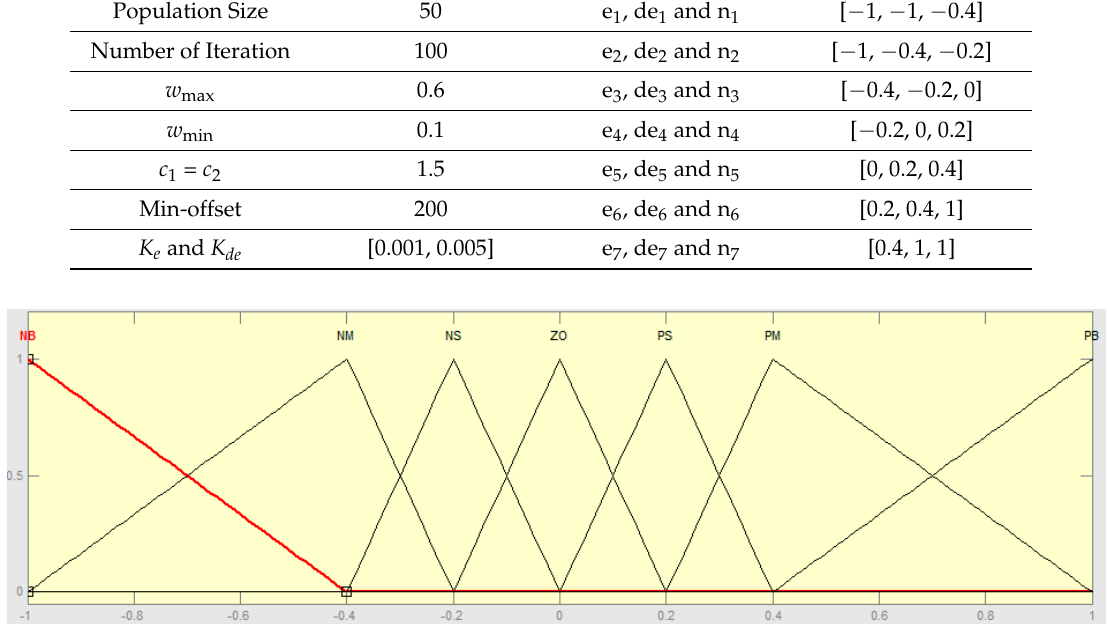
Table 3. Coefficients of Particle Swarm Optimization (PSO) algorithms.